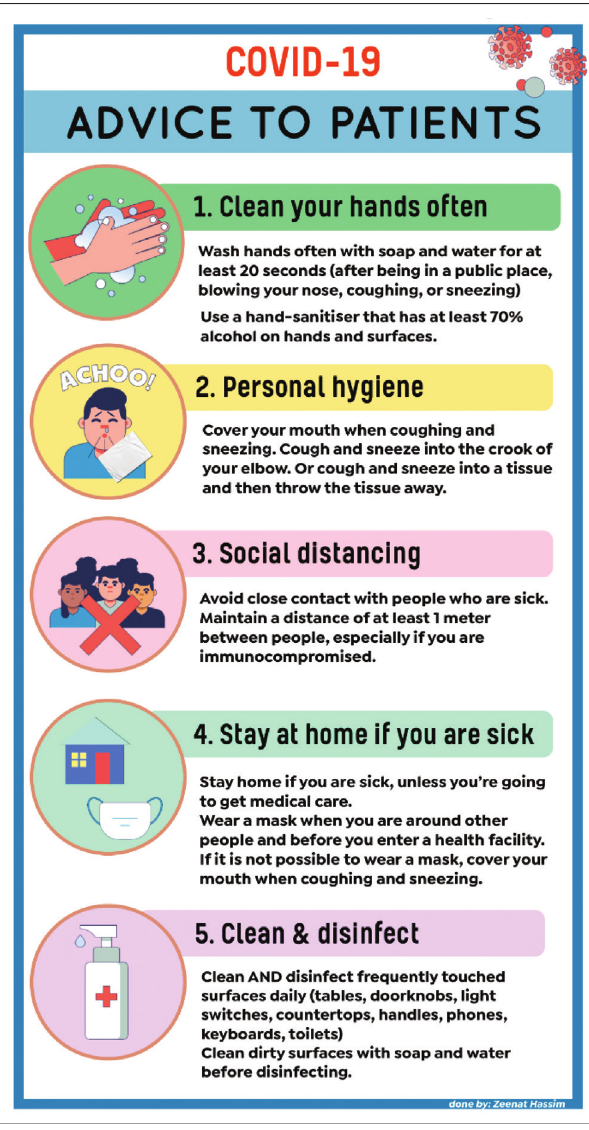
FIGURE 2: Advice to be given to patients and members of the public.